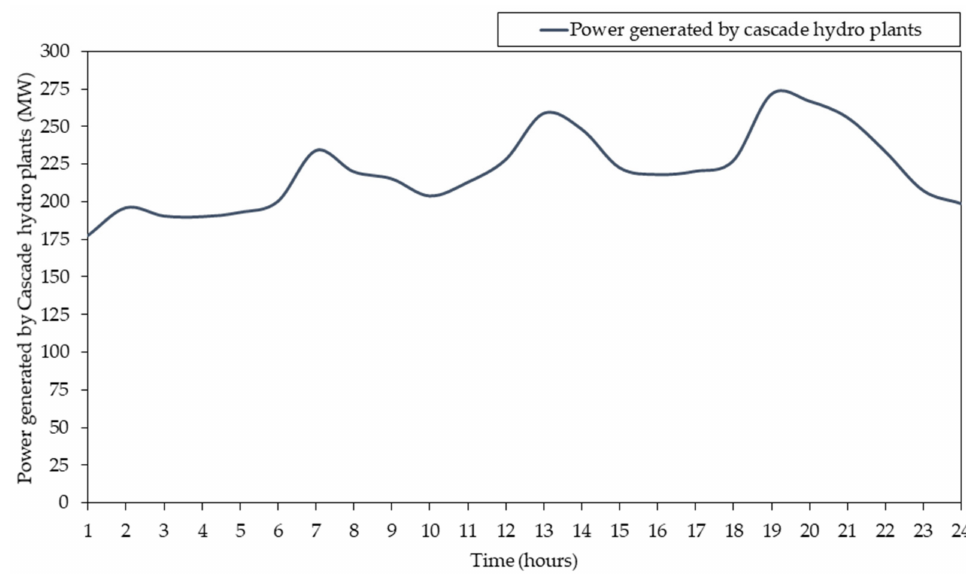
Figure 7. Electricity generation and dispatch by cascade hydroelectric plants through the grid operator (ESCOM).